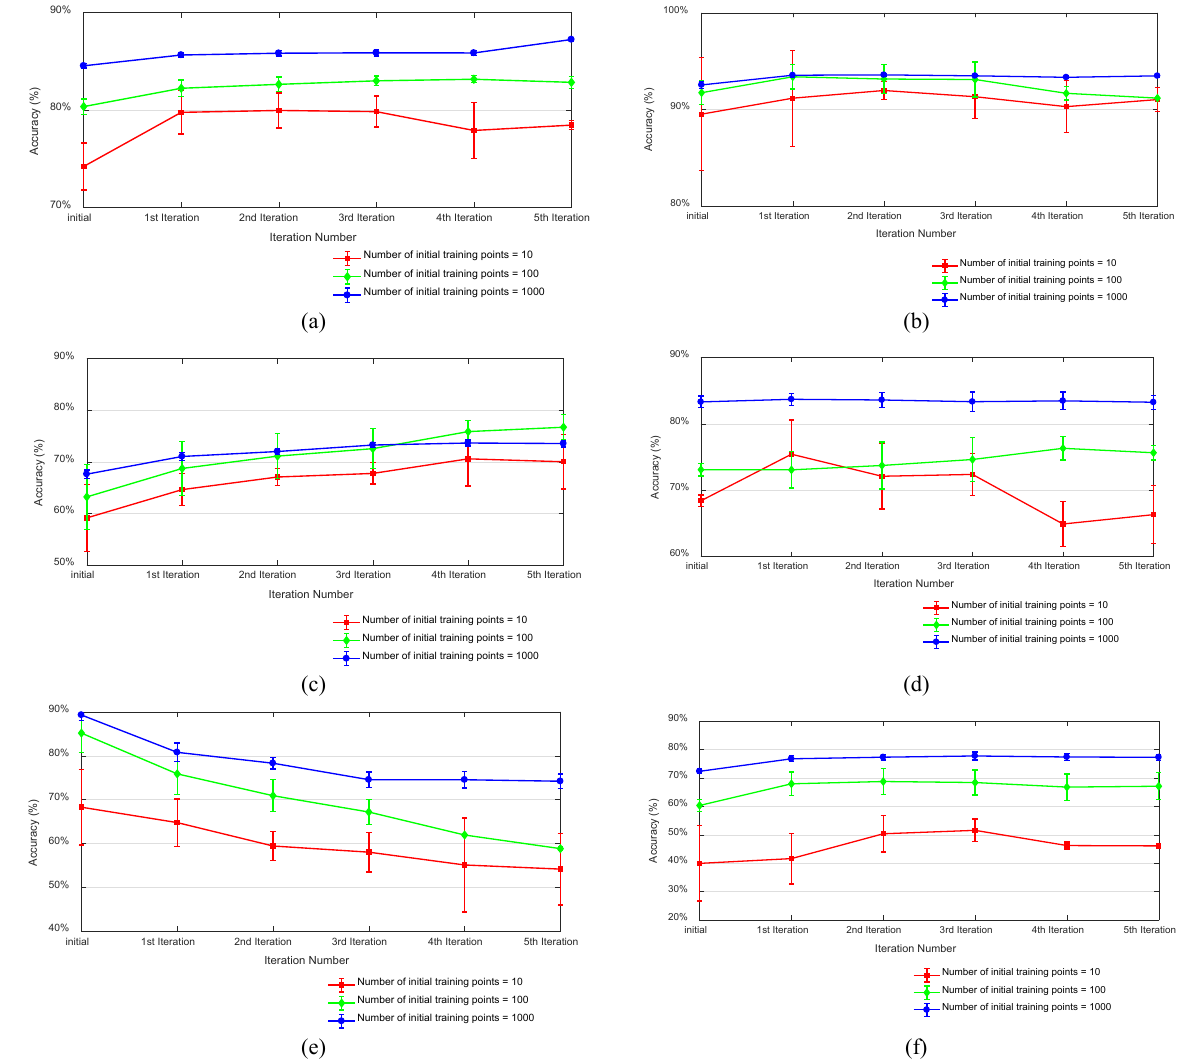
Figure 3. The trend of accuracy changes over iterations. (a) overall accuracy; (b) ground accuracy; (c) vegetation accuracy; (d) roofs accuracy; (e) façades accuracy; (f) others